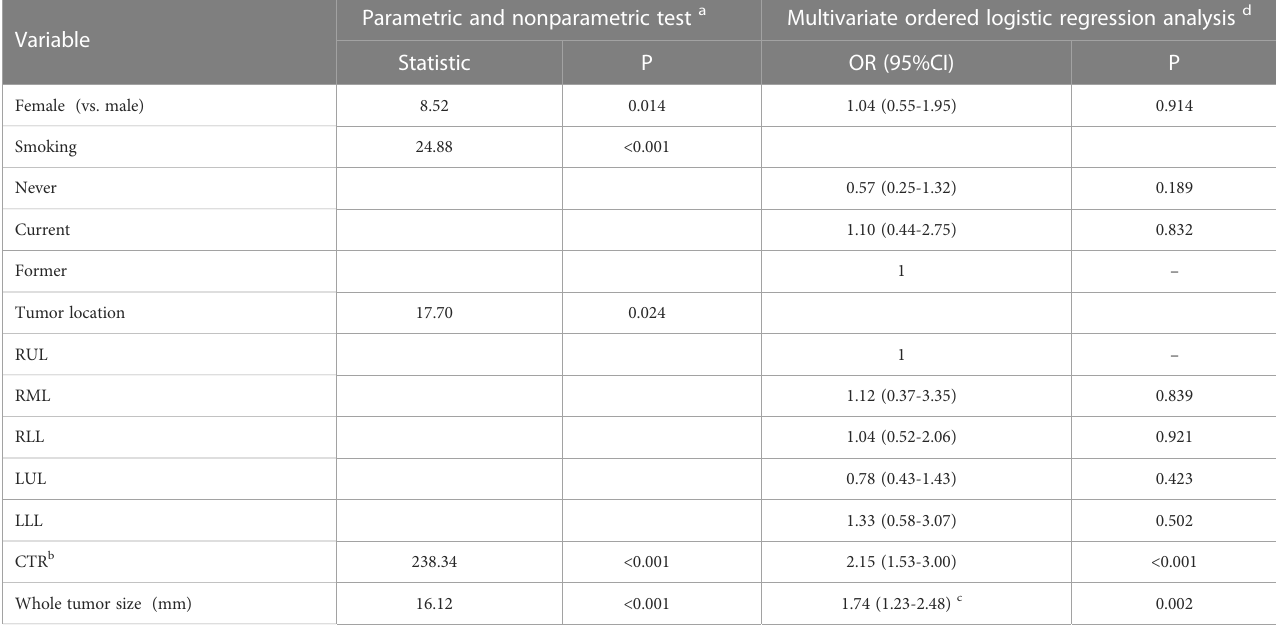
TABLE 2 Differences among the three histologic grades and results of multivariate ordered logistic regression analysis.